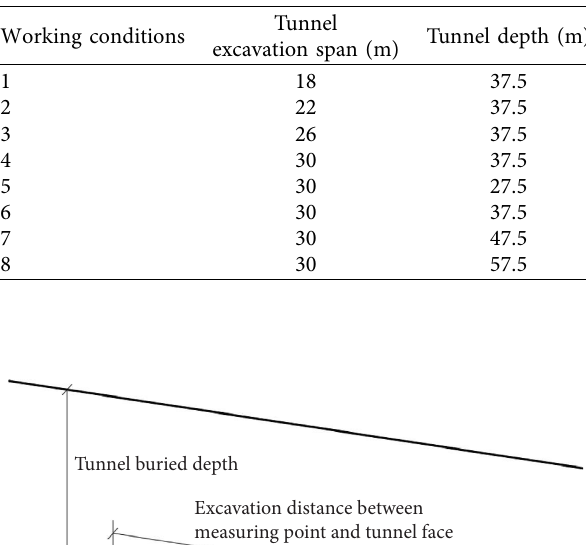
Table 2: Project excavation conditions.